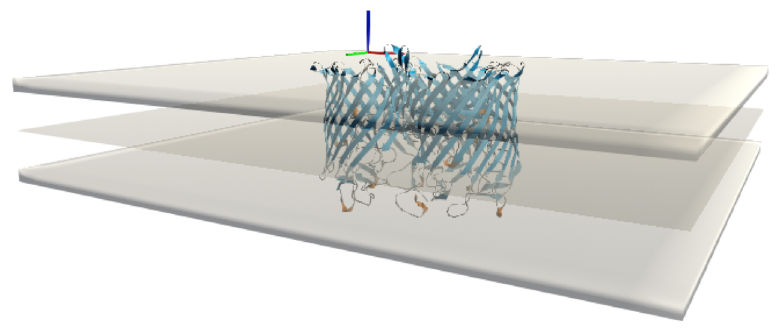
Figure 4. Illustration of maltoporin within a flat membrane reference mesh representing the centre of the bilayer, with both headgroup regions shown as thickened slabs in UnityMol.